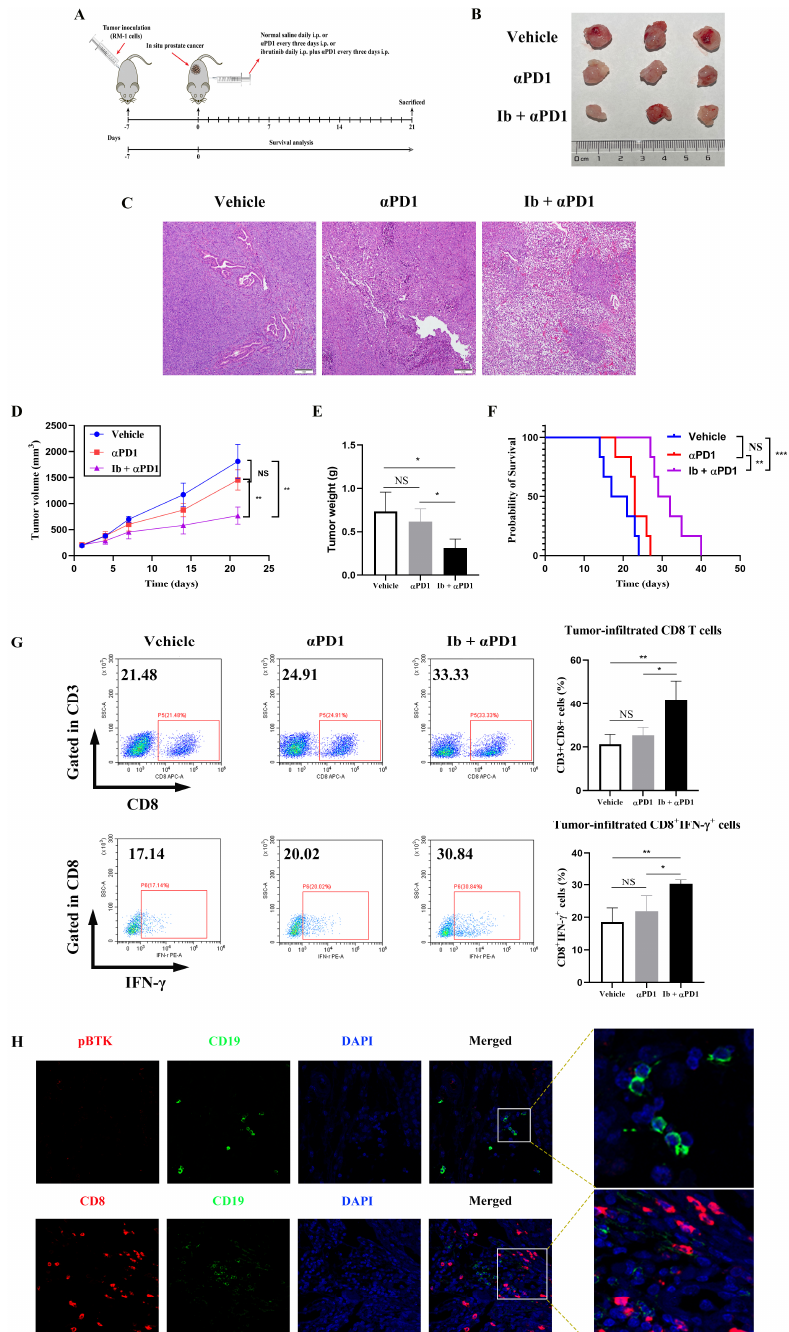
Figure 7. Ibrutinib synergizes with anti-PD-1 therapy to achieve great tumor control. ( A ) Experi- mental design and treatment strategy. See Materials and Methods for details. ( B ) Representative photographs show the gross appearance of RM-1 tumors in mice in each group. ( C ) HE staining shows noticeable pathological changes after combined treatment (original magnification: 100 × ). ( D , E ) Tumor volumes at the indicated times and weights were recorded in the three groups ( n = 4). ( F ) Survival of tumor-bearing mice in each group ( n = 6). ( G ) Flow cytometry plots show that the combined treatment enhanced the augmentation of tumor-infiltrating CD8 + T cells and CD8+IFN- γ + cells ( n = 4). ( H ) Representative mIHC images display inhibition of BTK phosphorylation in B cells and augmentation of CD8 + T cells in tumors of mice treated with ibrutinib plus α PD-1 (original magnification: 400 × ). A p value less than 0.05 was considered statistically significant. *, p < 0.05; **, p < 0.01; ***, p <